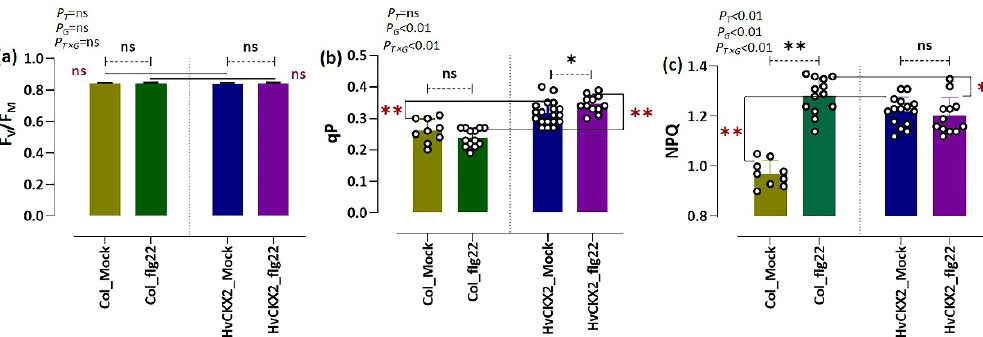
Figure 3. ( a – c ) Photosynthetic parameters of Arabidopsis plants treated with or without 1 µM flg22, represented in terms of maximum PSII quantum yield (F V /F M ), coefficient of photochemical quenching of chlorophyll fluorescence (qP), and non-photochemical quenching (NPQ). Bars represent the mean of at least ten biological replicates. Error bars indicate standard deviation. Asterisks represent statistical differences between flg22-treated Arabidopsis plants and their mock plants (highlighted with black-coloured asterisk) or between Col-0 and HvCKX 2 plants within the same treatment (highlighted with red-coloured asterisk) (* significant at p < 0.05; ** significant at p < 0.001; ns, not significant; two-sided Student’s t -test). Probability value ( p ) indicates the results of two-factor ANOVA (letter